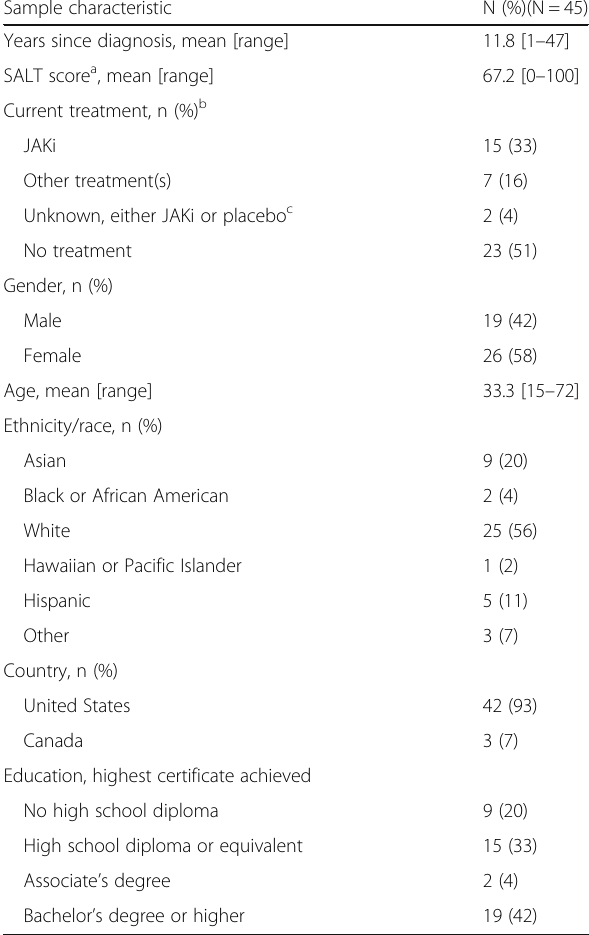
Table 2 Sample characteristics Sample